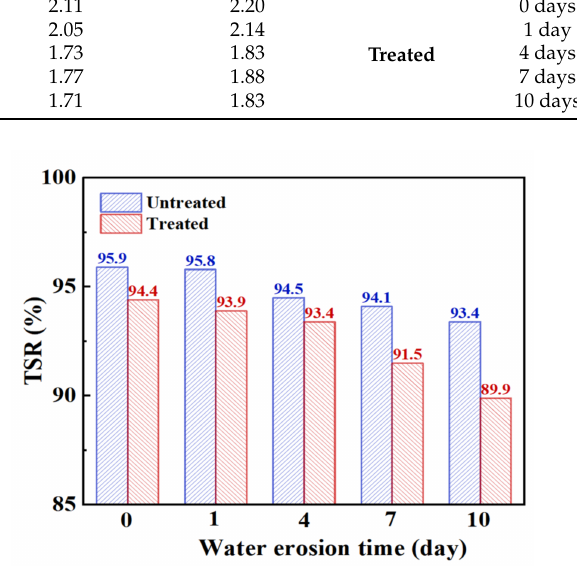
Figure 10. Freeze–thaw splitting strength ratio of steel slag asphalt mixture with different water erosion